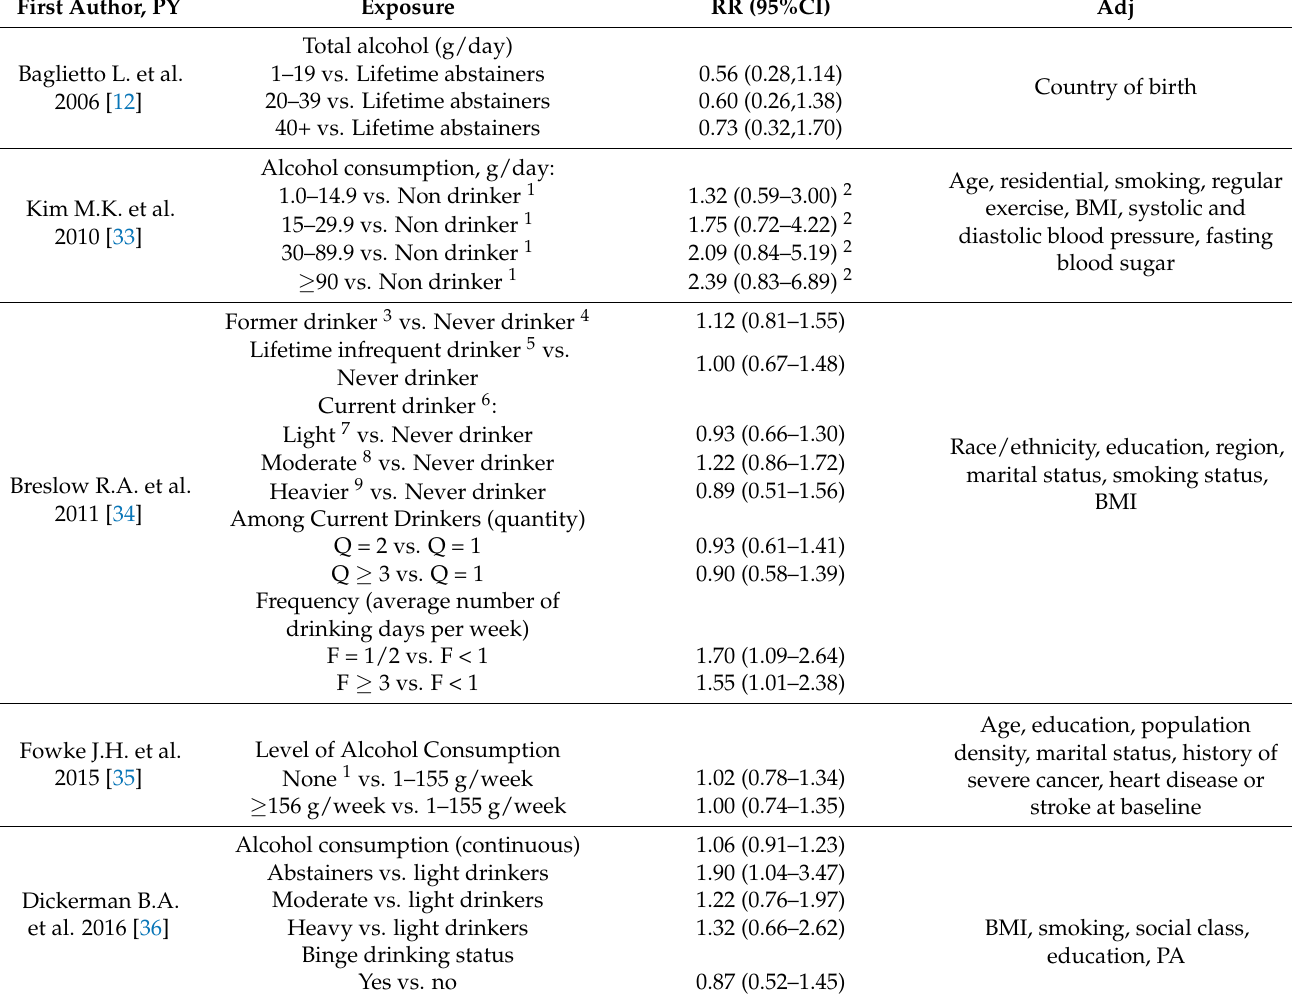
Table 2. Summary results of the studies included in the review that reported on the association between alcohol intake and the risk of death from prostate cancer in healthy